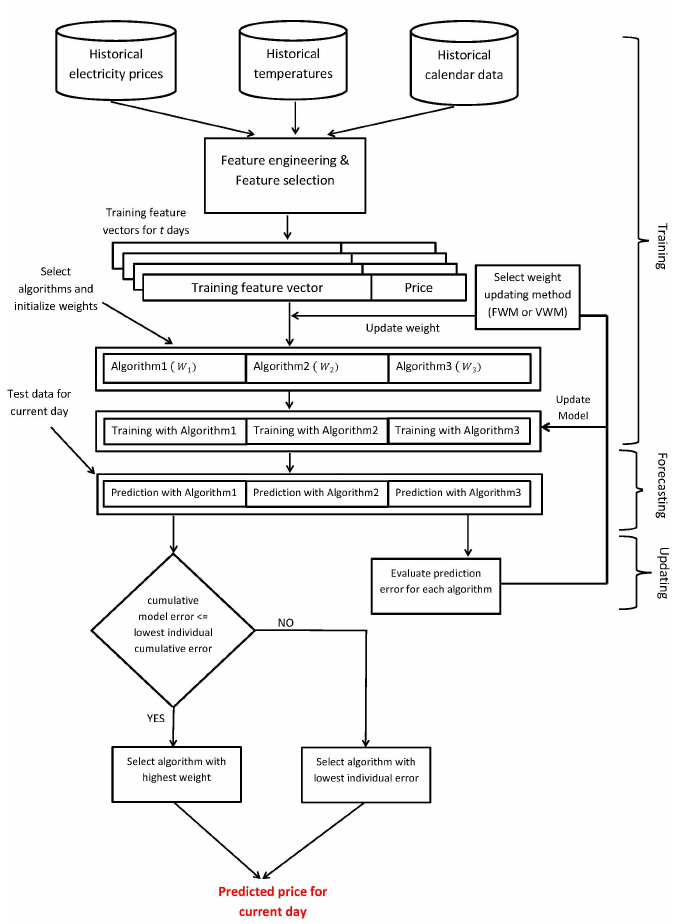
Figure 1. Overview of the proposed ensemble model demonstrated with three participating